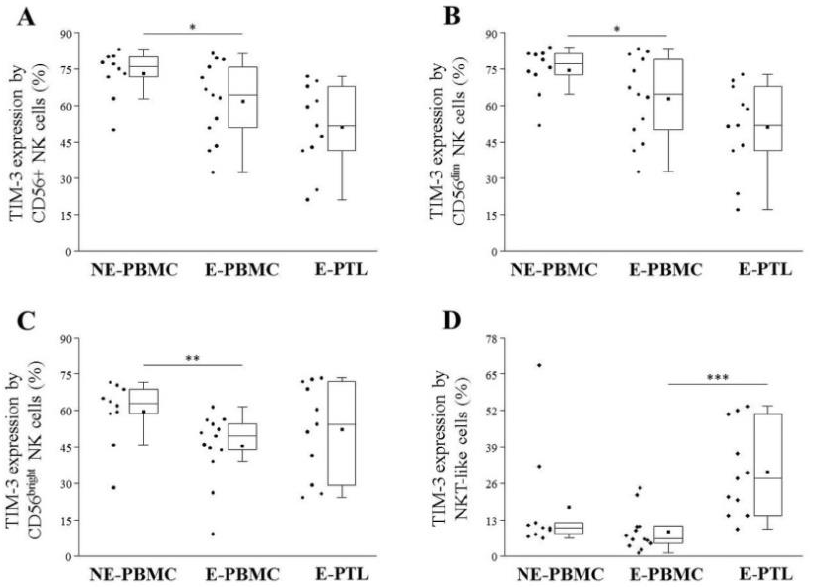
Figure 4. Comparison of the TIM-3 receptor expression by peripheral (PBMC) and peritoneal (PTL) CD56 + NK ( A ), CD56 dim NK ( B ), CD56 bright ( C ) and NKT-like ( D ) cell subpopulations in non-endometriotic (NE) women and patients with endometriosis (E). The solid bars represent medians of 10, 12, and 11 determinations, the boxes show the interquartile ranges, and the whiskers show the most extreme observations. The middle square within the box shows the mean value. Statistically significant differences for p -values of *** < 0.01, ** < 0.03, and * < 0.05 are indicated.